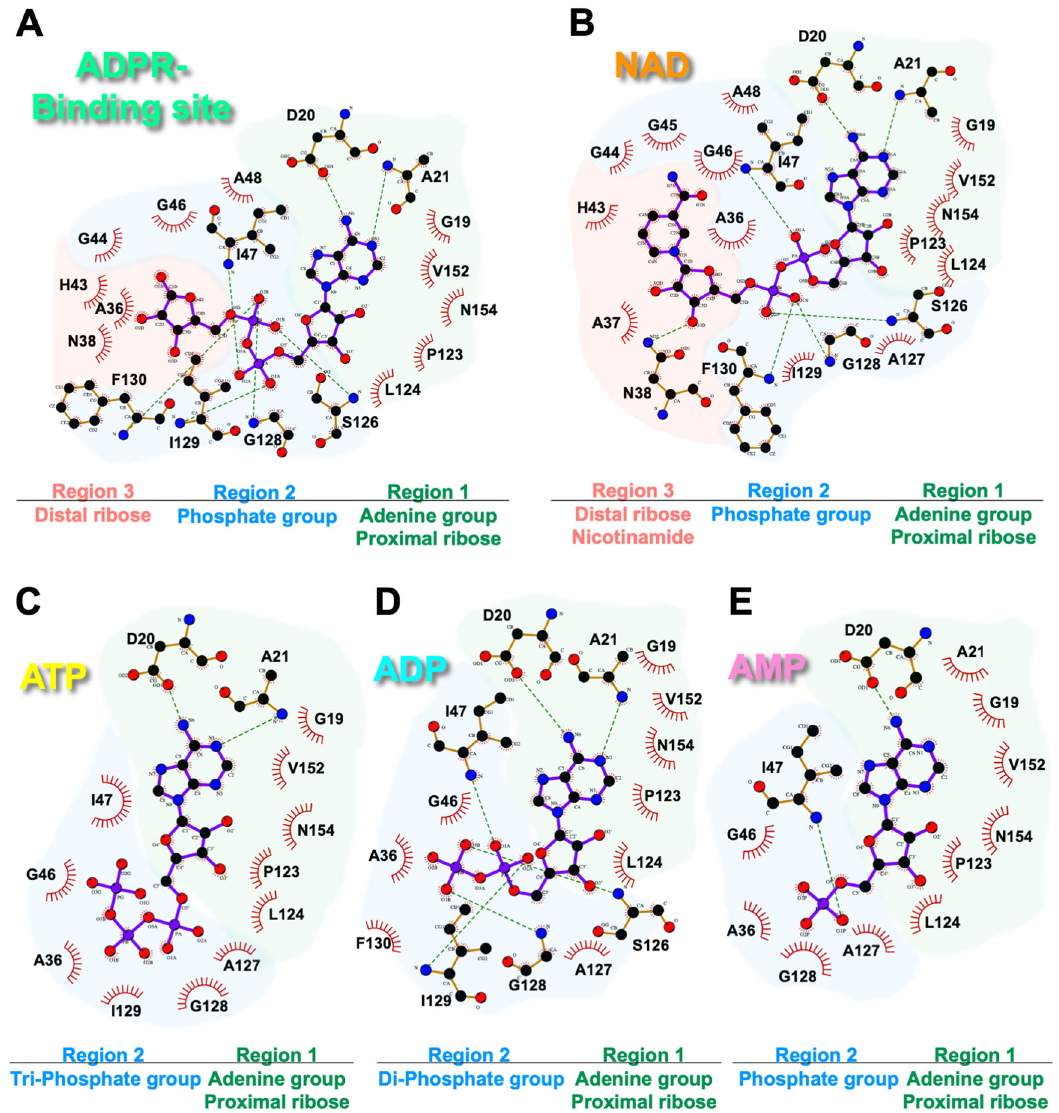
Fig. 3 Ligplot diagrams for NAD metabolites coordinated with the MERS-CoV macro domain. Components of A ADPR-binding, B NAD-binding, C ATP- binding, D ADP-binding, and E AMP-binding sites are shown. According to the chemical structure of each ligand, the binding sites are classed in several regions: region 1 in green, region 2 in marine, and region3 in salmon. Covalent bonds of ligands are in purple, covalent bonds of amino acids are in brown, and hydrogen bonds are in green dashed lines. Protein residues in hydrophobic contacts with NAD metabolites are represented by eyelash